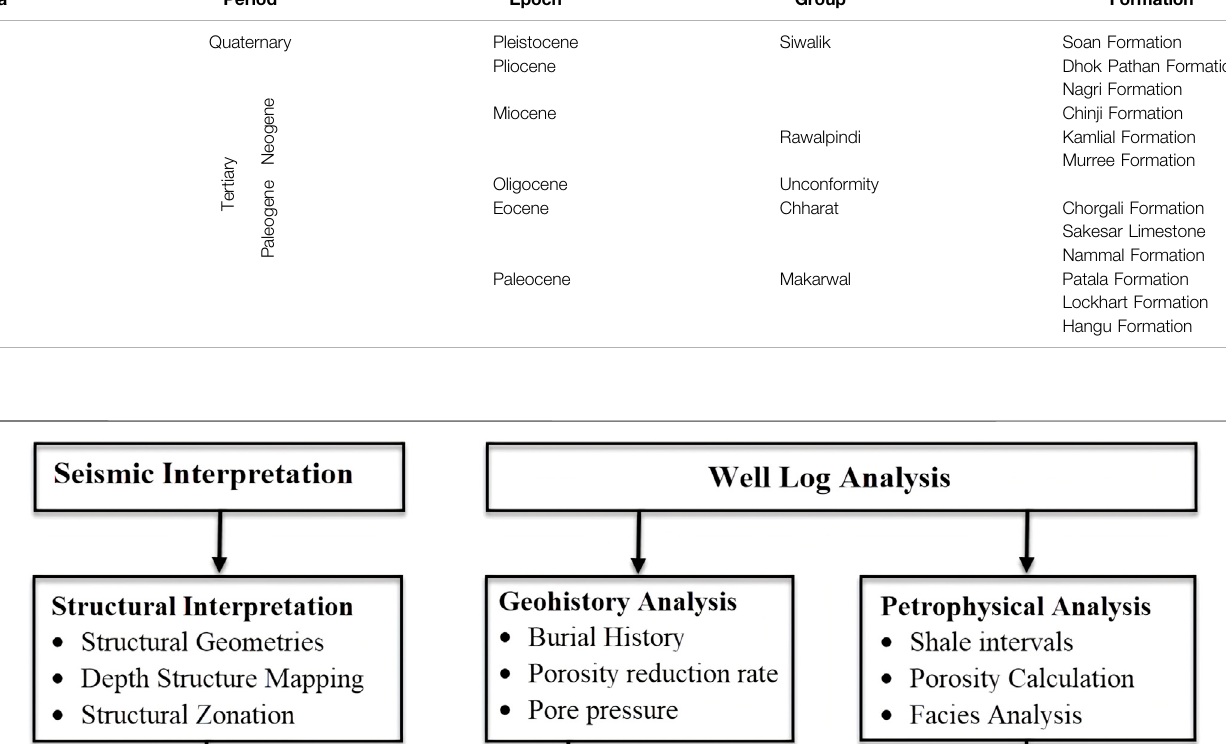
Frontiers in Earth Science |